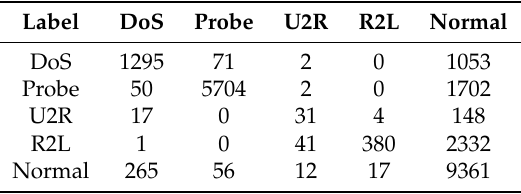
Table 8. Confusion matrix of SVM.